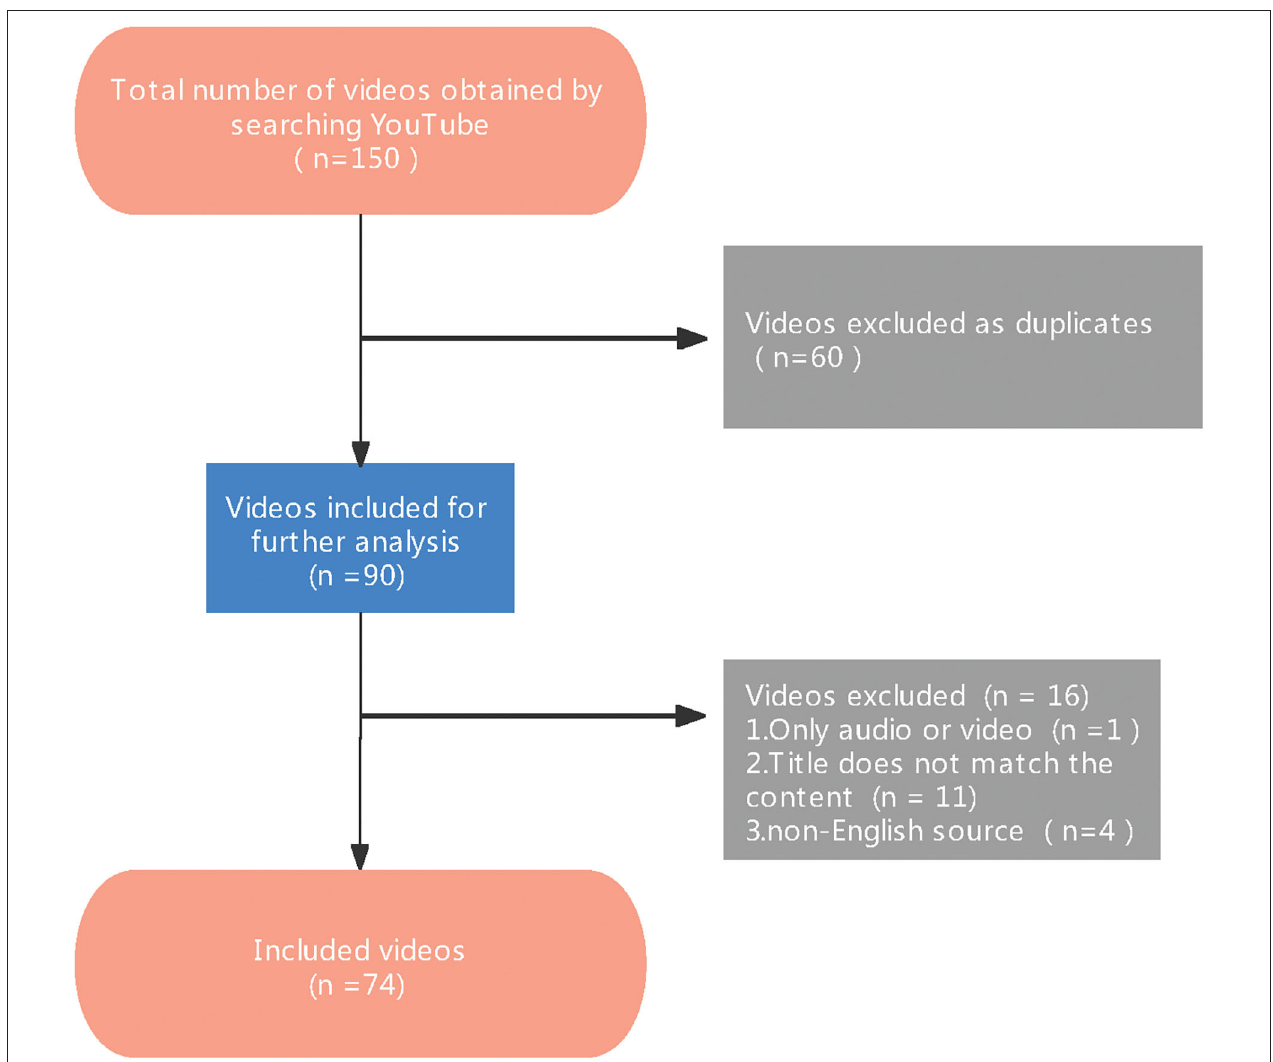
FIGURE 1 | Flowchart demonstrating the process of video